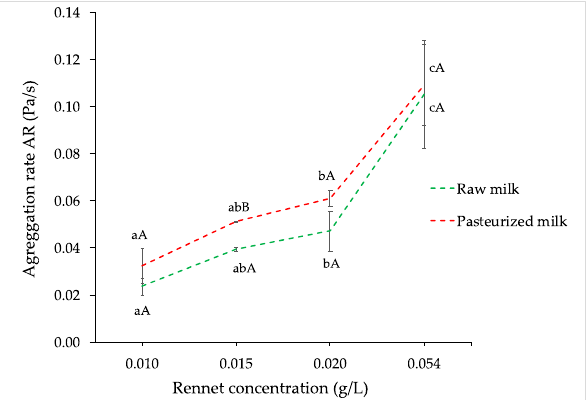
Figure 3. Influence of rennet concentration and heat treatment of milk on aggregation rate AR (Pa/s). Values with different lowercase letters (a, b, c) represent differences between levels of rennet concentrations, different uppercase letters (A, B) represent differences between milk heat treatments (raw/pasteurized). Mean comparisons were performed with the Tukey HSD test ( p < 0.05).